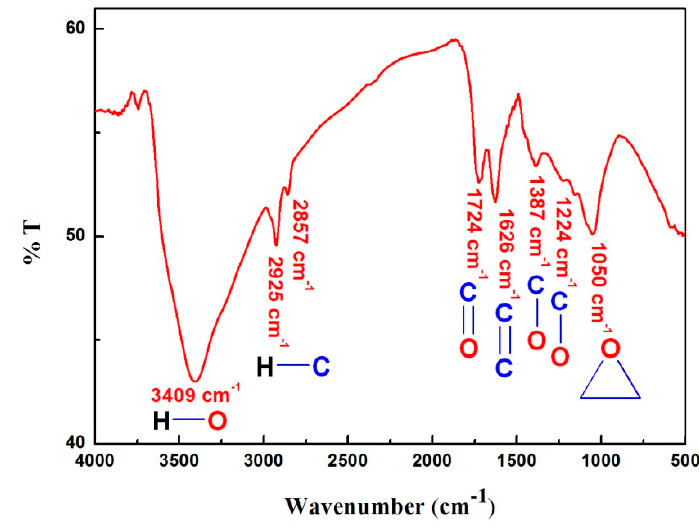
Figure 4. FT-IR spectrum curve of GO in KBr disc.